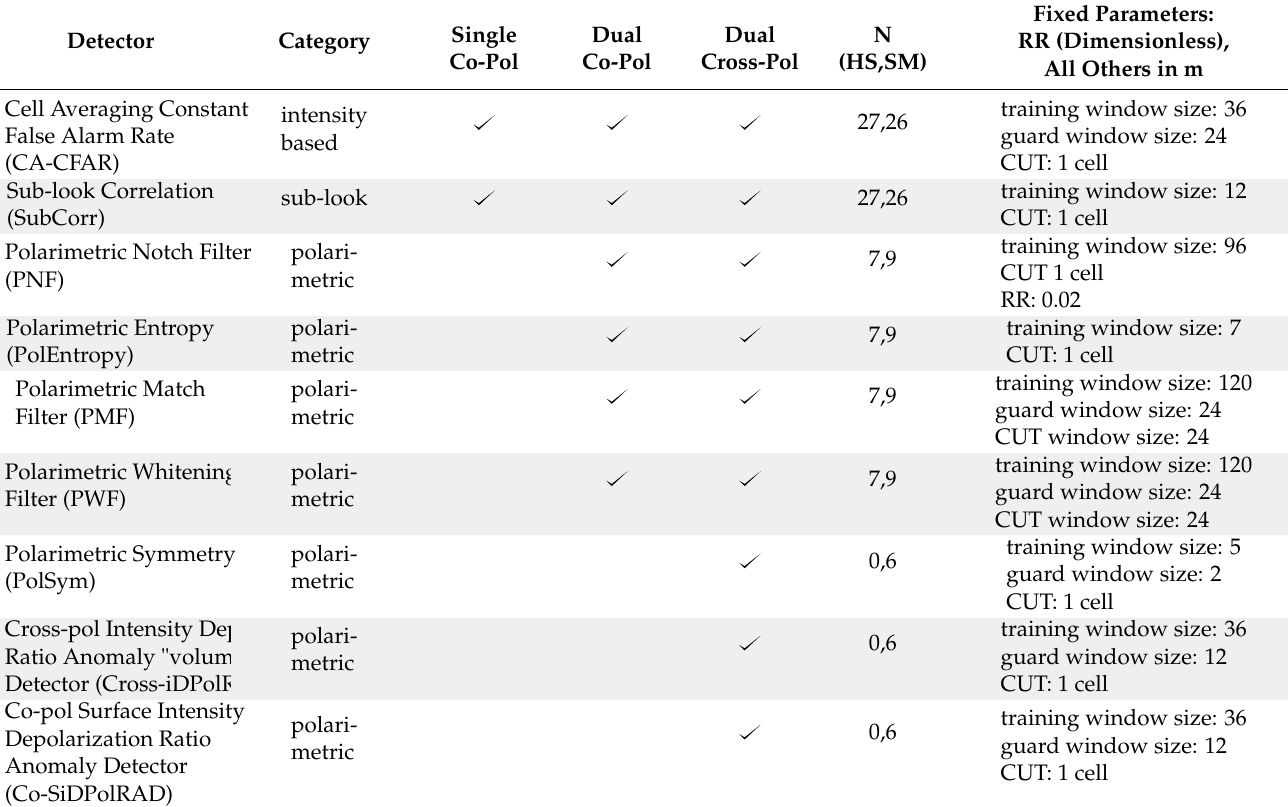
Table 2. VDSs under test, applicable polarimetric channels and total number of samples (n) per